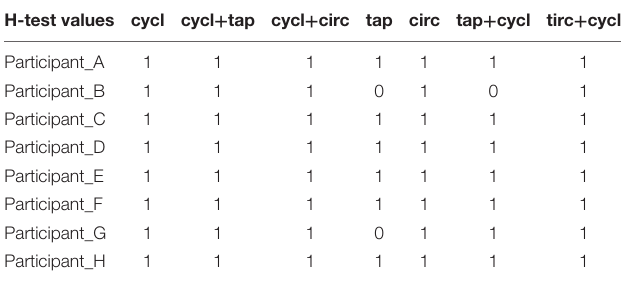
TABLE 1 | Results of one-sample t -test for the null hypothesis that the original time series has a similar α -DFA that its shuffled surrogates ( n =